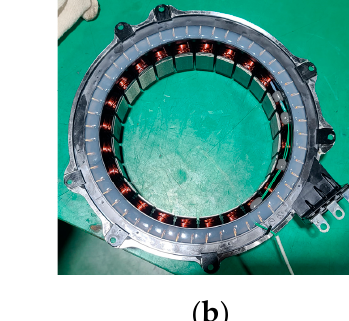
Figure 23. Final model production photograph: ( a ) Rotor production model, ( b ) Stator production model.